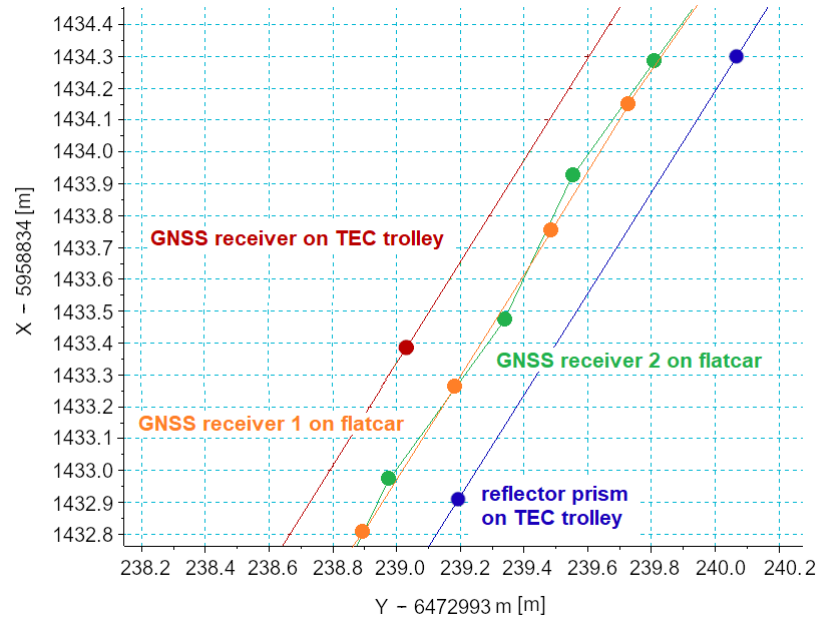
Figure 8. Points measured using GNSS techniques (kinematics), and tacheometry presented on the grid of the coordinates of PL-2000 system.